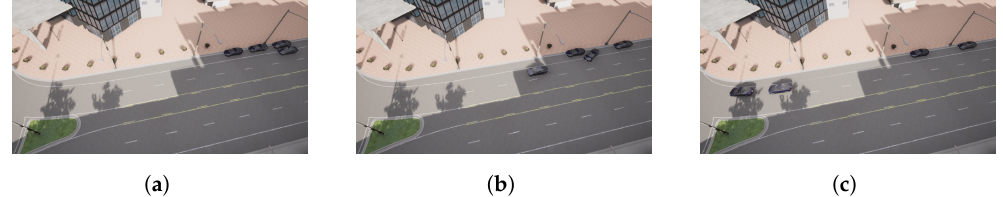
Figure 16. Follower 1 pick-up process. ( a ) Follower 1 waiting. ( b ) Follower 1 de-parking. ( c ) Follower 1 joining.